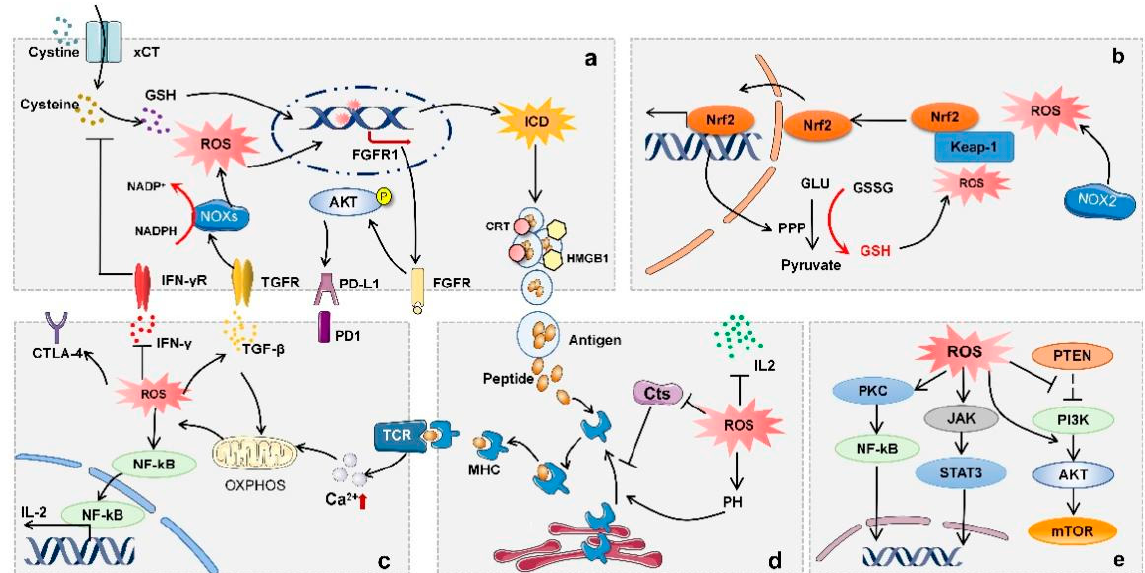
Figure 4. The role of ROS in regulating immune cells. ( a ) Tumor cells: IFN- γ signaling downregulates the expression of xCT, thereby decreasing the synthesis of GSH. TGF- β signaling activates NADPH oxidase to increase ROS production. Oxidative damage ultimately leads to cancer cell death and induces ICD, resulting in significant production of tumor neoantigens. In addition, ROS can promote the expression of FGFR1 to activate the Akt signaling pathway, contributing to a significant increase in PD-L1 protein. ( b ) MDSCs: ROS generated by NOX2 induce a conformational change in Keap1 that releases nuclear factor erythroid 2-related factor 2 (Nrf2). The activation of Nrf2 leads to the increased expression of GSH-transmitting PPP, and, subsequently, increased glutathione can affect MDSCs differentiation. ( c ) The stimulation of TCR induces the release of intracellular calcium ions to activate OXPHOS. ROS generated through OXPHOS then activate NF-kB and induce IL-2 expression, leading to enhanced T-cell proliferation. ( d ) DCs: ROS can affect antigen processing by regulating pH and inhibiting Cts (performing proteolytic activity at a specified pH), thereby affecting the binding of antigens to MHC molecules. ( e ) B cells: ROS participates in BCR signaling pathways, including PKC/NF- κ B and PI3KA/mTOR.